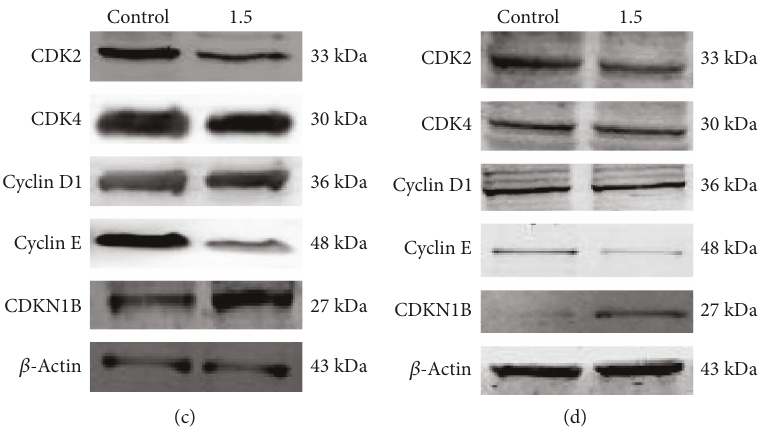
Figure 2: Eca109 and Ec9706 cells were exposed to various concentrations of pristimerin (0, 1.0, 1.5, and 4.0 μ mol · L – 1 ) for 48 hours followed by the cell cycle distribution assay and altered CDK2, CDK4, cyclin E, and CDKN1B. The percentage of cells in G0/G1, S, and G2/M phases of the cell cycle following pristimerin treatment in Eca109 and Ec9706 cells (a, b). Western blotting was used to detect the ratios of CDK2, CDK4, cyclin E, and CDKN1B expression in Eca109 (c) and Ec9706 (d) cells treated with pristimerin (1.5 μ mol · L – 1 , 48 hours). Relative expression of CDK2, CDK4, cyclin E, and CDKN1B was normalized to β -actin. Data are the average of three independent experiments for each group. Comparable results were observed from another three experiments. ∗ P < 0 05 versus control group.